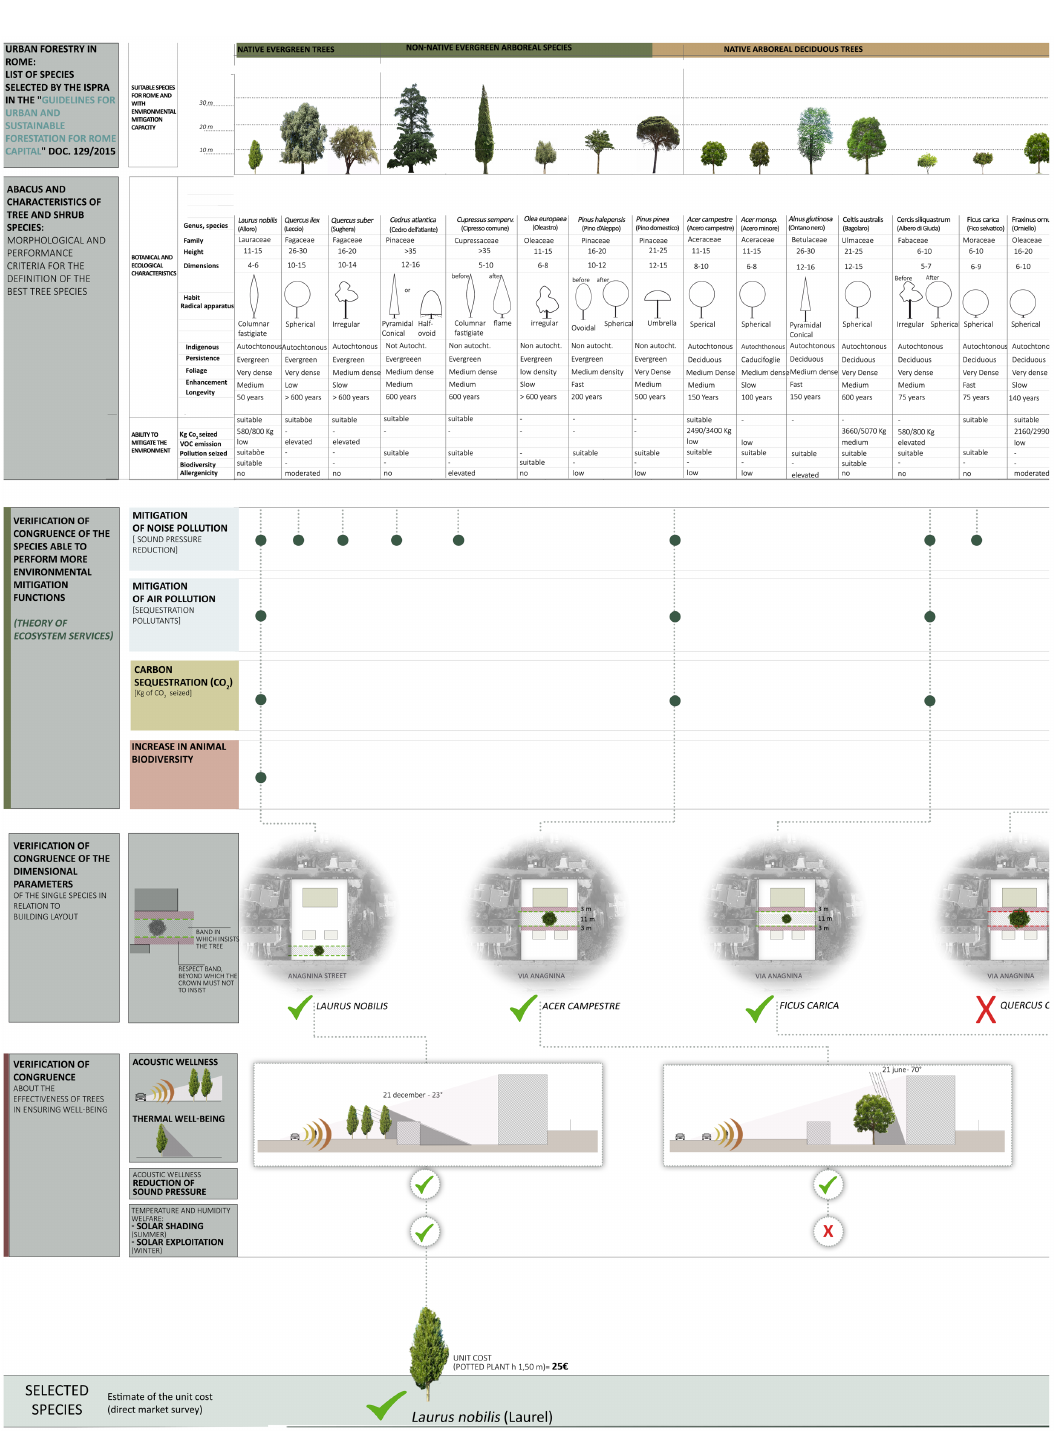
Figure 4. Example of classification, evaluation and identification of tree and / or shrub species to be included in the intervention area to be covered by greenery. (Source: Elaboration from E. Sonnino’s Ttbles degree thesis at the Faculty of Architecture of the Sapienza University of Rome -IT) Table 6 for each one specifies the number of trees and / or linear metres of shrub and the corresponding unit purchase